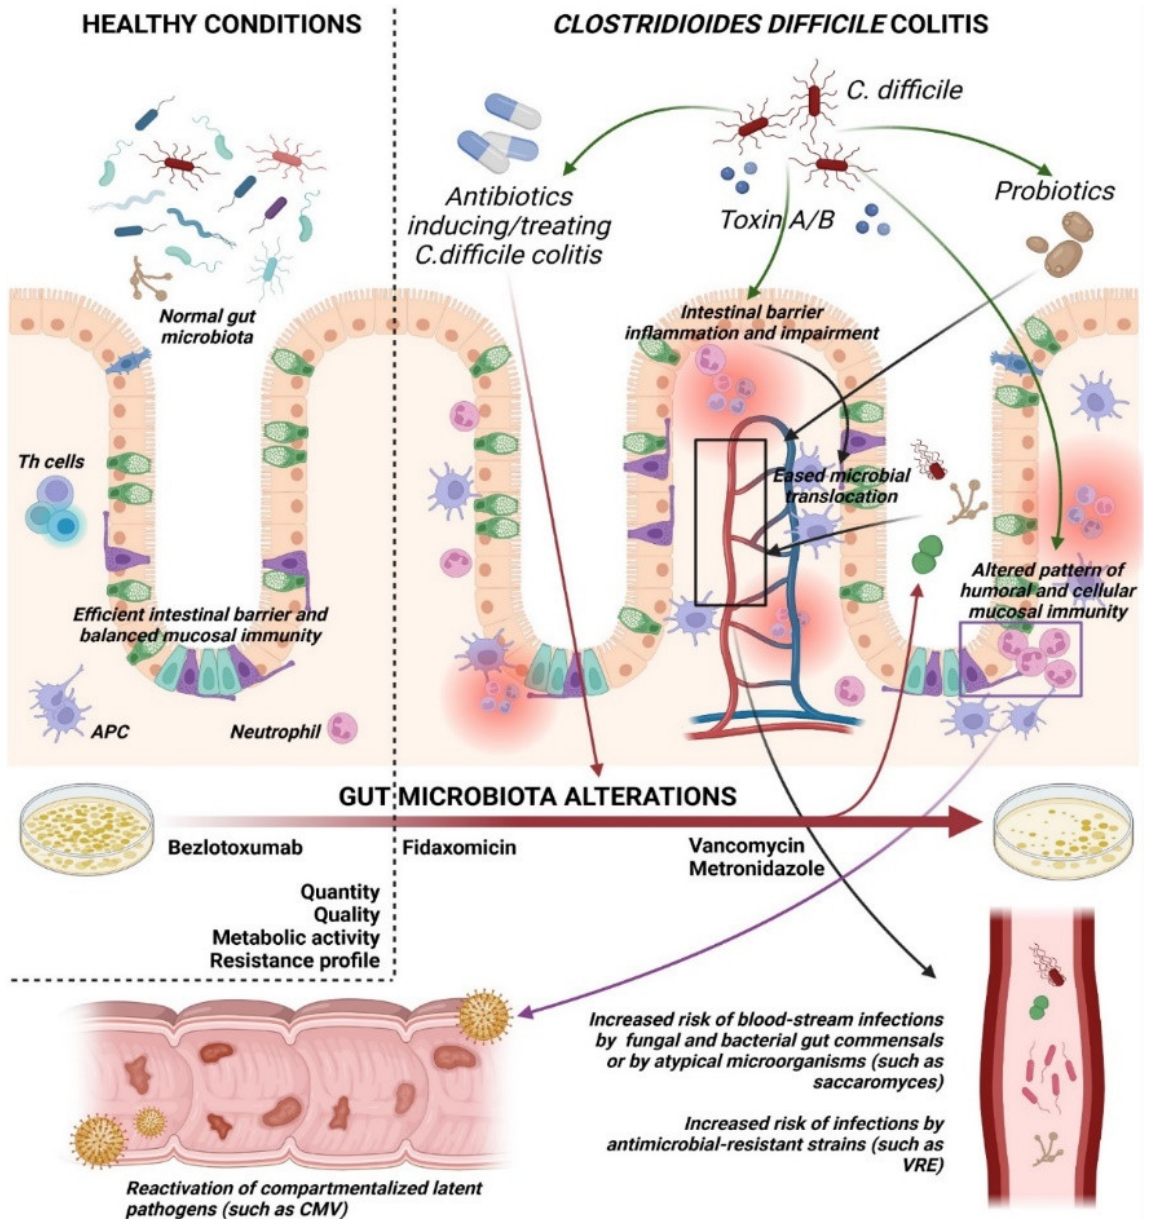
Figure 1. Schematic representation of predisposing factors and mechanisms underlying bacterial, fungal, and viral infections that develop concomitantly or subsequently to Clostridioides difficile colitis. Legend: Th cells, T helper lymphocytes; APC, antigen presenting cells; CMV, Cytomegalovirus; VRE, Vancomycin-resistant Enterococcus spp. Table 1. Summary of literature studies reporting period prevalence data on bacterial and/or fungal blood-stream infection during and following Clostridioides difficile colitis.